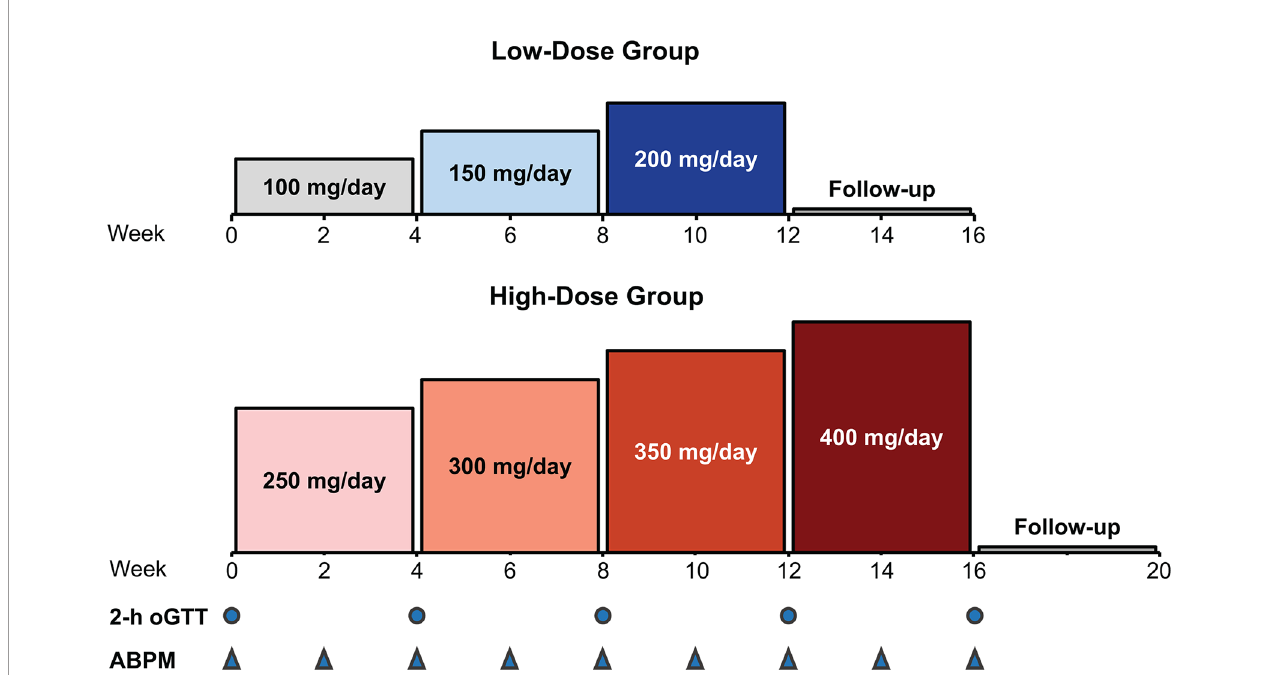
FIGURE 1 | Study design: dose escalation in the low- and high-dose groups. ABPM, ambulatory blood pressure monitoring; oGTT, oral glucose tolerance